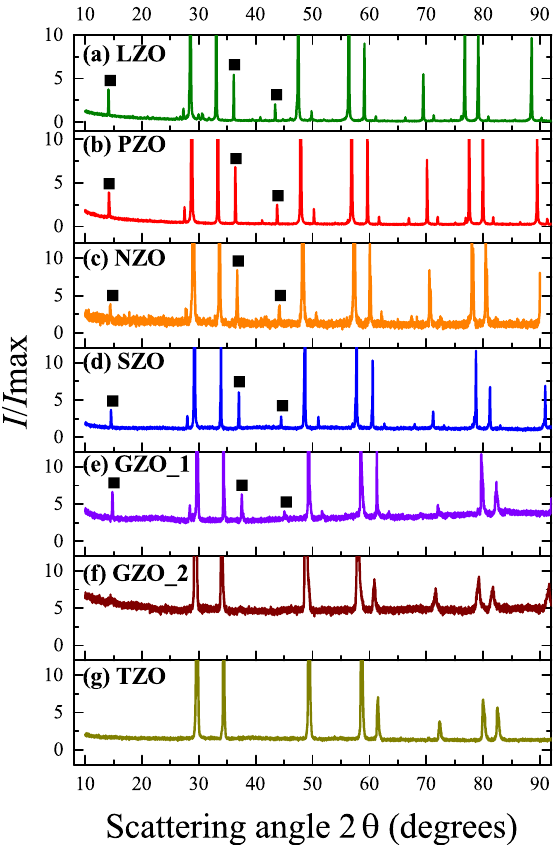
Figure 3. ( a – g ) Room temperature X-ray diffraction patterns of polycrystalline samples of A 2 Zr 2 O 7 (with A “ La Ñ Tb) plotted to show the low intensity Bragg peaks. The experimental profiles are given in relative intensities as a function of the scattering angle 2 θ . LZO ( a ); PZO ( b ); NZO ( c ); SZO ( d ); and GZO_1 ( e ) samples have a cubic Fd ¯3 m pyrochlore structure (” (cid:110) ” indicate the low angle superlattice reflections of the pyrochlore structure). GZO_2 ( f ) and TZO samples ( g ) crystallize in the cubic Fm ¯3 m defect-fluorite structure. The two Gd 2 Zr 2 O 7 samples were prepared using the different synthesis conditions given in Table 3.